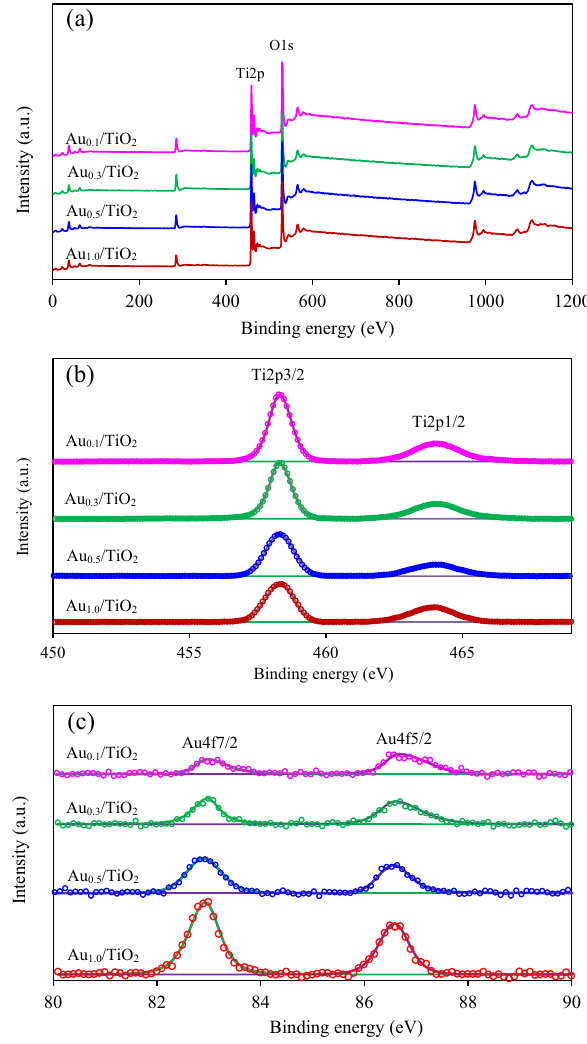
Figure 4. ( a ) Representative wide scan XPS spectra, ( b ) Ti2p and ( c ) Au 4f XPS spectra of Au x /TiO 2 NPs photocatalysts synthesized by photodeposition and their particle size distributions at different gold loadings in the range of 0.1–1.0